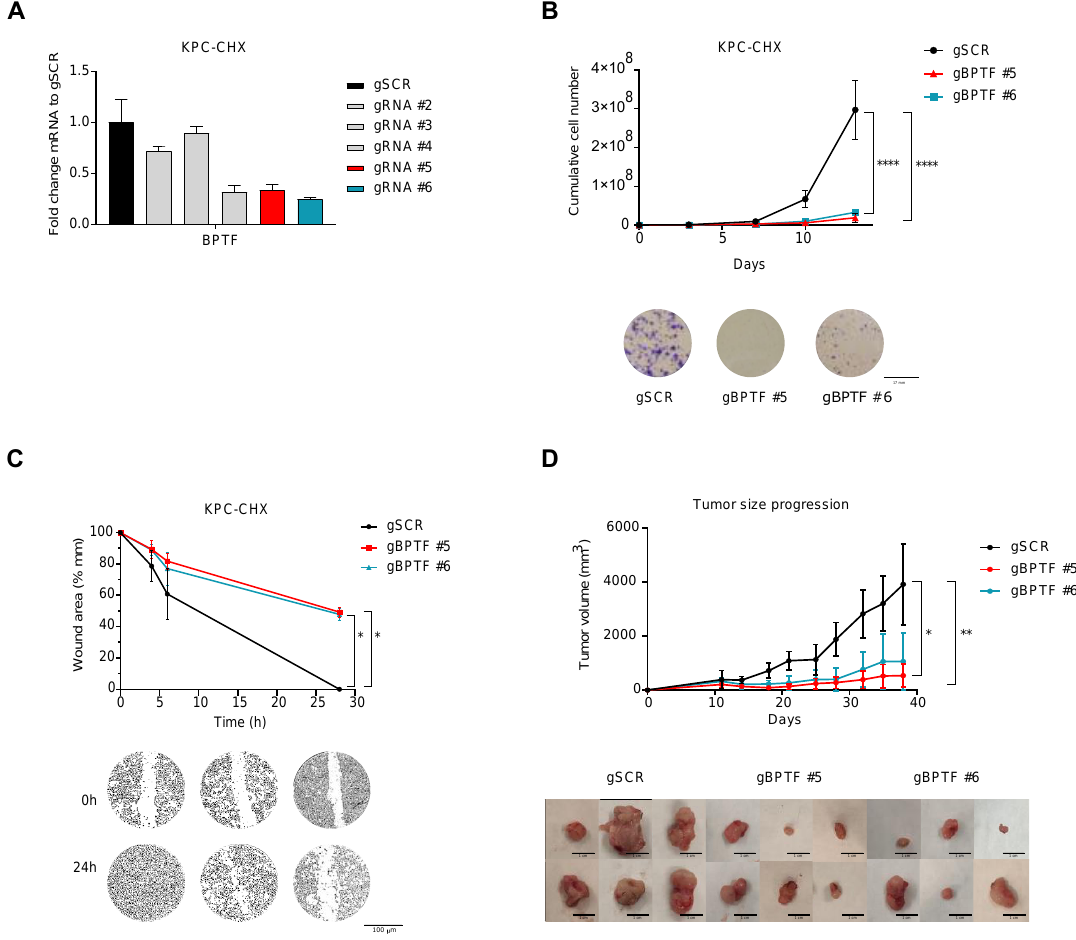
Figure 1. BPTF downregulation impairs tumour progression in a syngeneic KPC mouse model. ( A ) qRT-PCR for BPTF expression upon silencing with five specific gRNAs compared to non-targeted (gSCR) in KPC cell line; n = 3. ( B ) Proliferation and colony assay of BPTF-interfered (gBPTF #5 and gBPTF #6) cells compared to non-targeted (gSCR) in KPC cell line; n = 3. ( C ) Wound-healing assay of BPTF-interfered (gBPTF #5 and gBPTF #6) cells compared to non-targeted (gSCR) for 4, 6, and 24 h in KPC cell line; n = 3. ( D ) Tumour volumes in C57/BL6c mice subcutaneously implanted with BPTF-silenced (gBPTF #5 and gBPTF #6) KPC cells or non-targeted control cells (gSCR) by CRISPRi; tumours were measured for 37 days, n = 8. Representative images of the different tumours. Significance was considered for * p < 0.05, ** p < 0.01, and **** p <